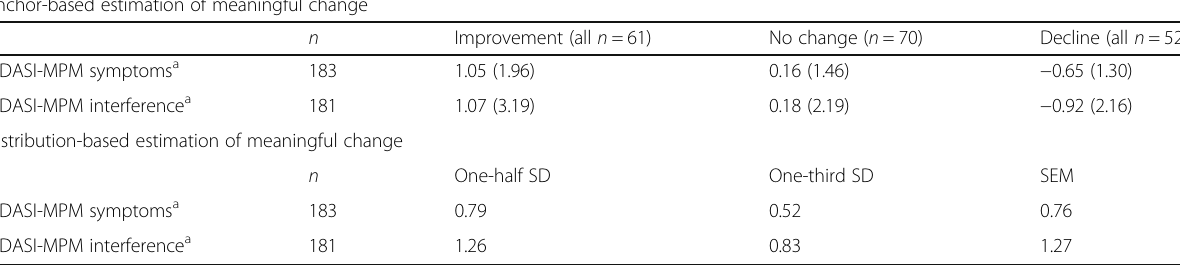
Table 6 Meaningful change estimation using 2 different approaches Anchor-based estimation of meaningful change n